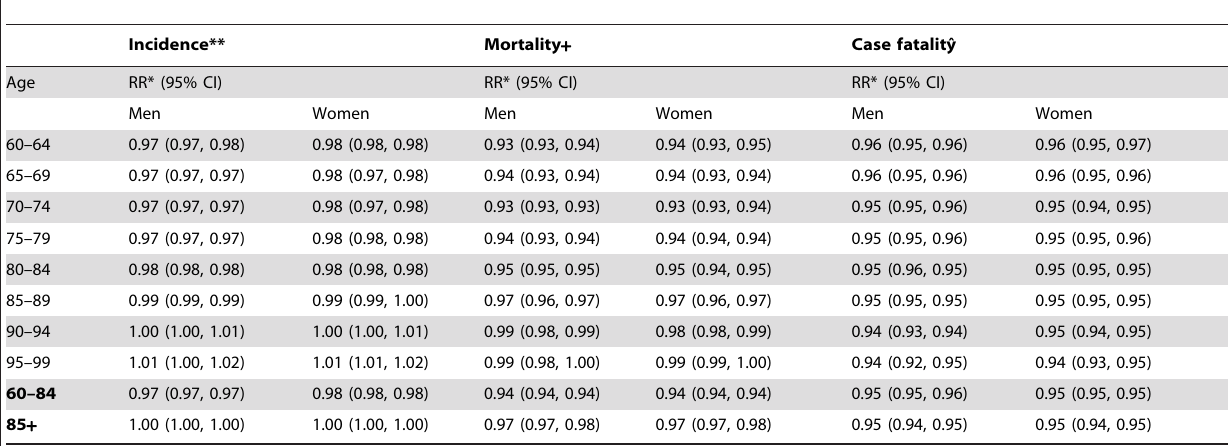
Table 2. Average annual change in MI between 1994 and 2010, ages 60–99 years, men and women.